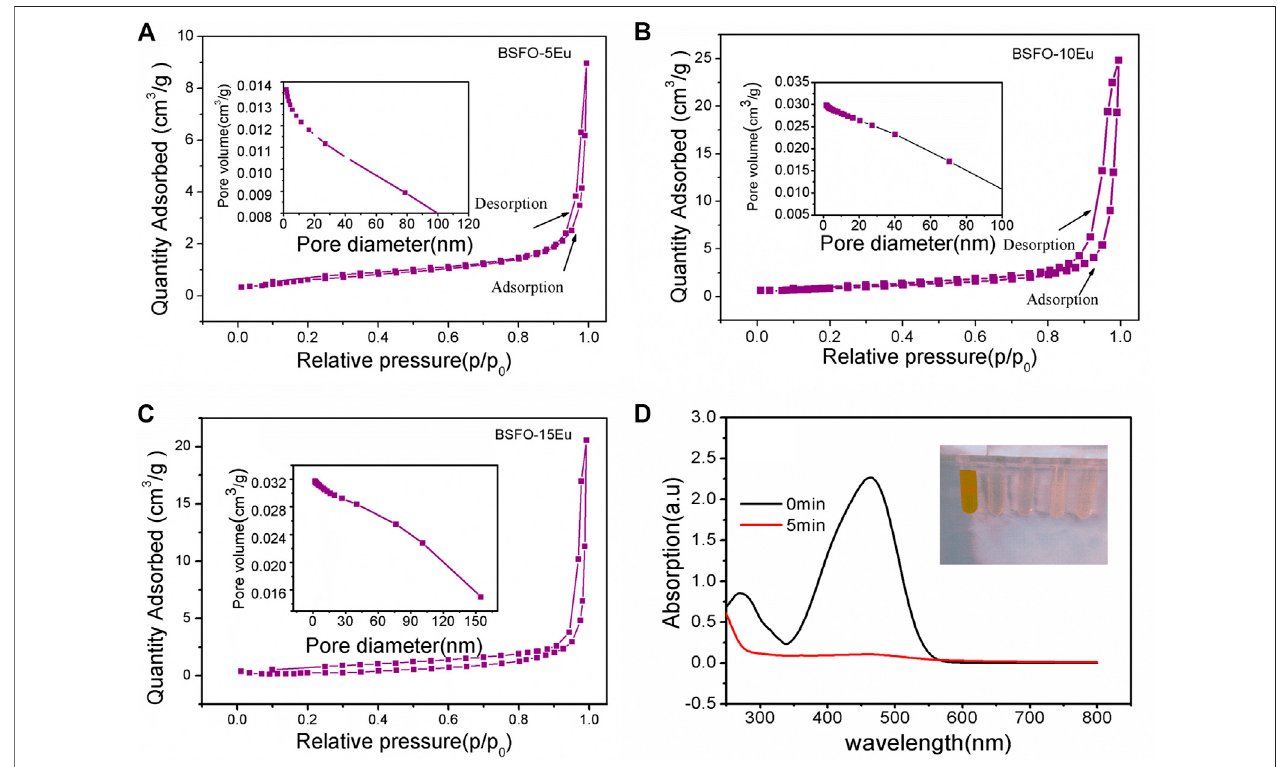
FIGURE 5 | N 2 adsorption – desorption isotherms and the corresponding pore-size distribution curves (inset) of the as-prepared samples: (A) BSFO-5Eu, (B) BSFO-10Eu, and (C) BSFO-15Eu. (D) Adsorption effect of methyl orange of BSFO-5Eu.